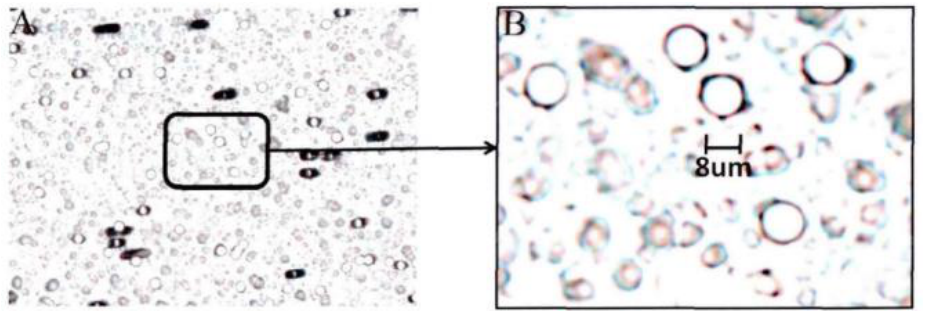
Figure 2. Microporous membrane structure.